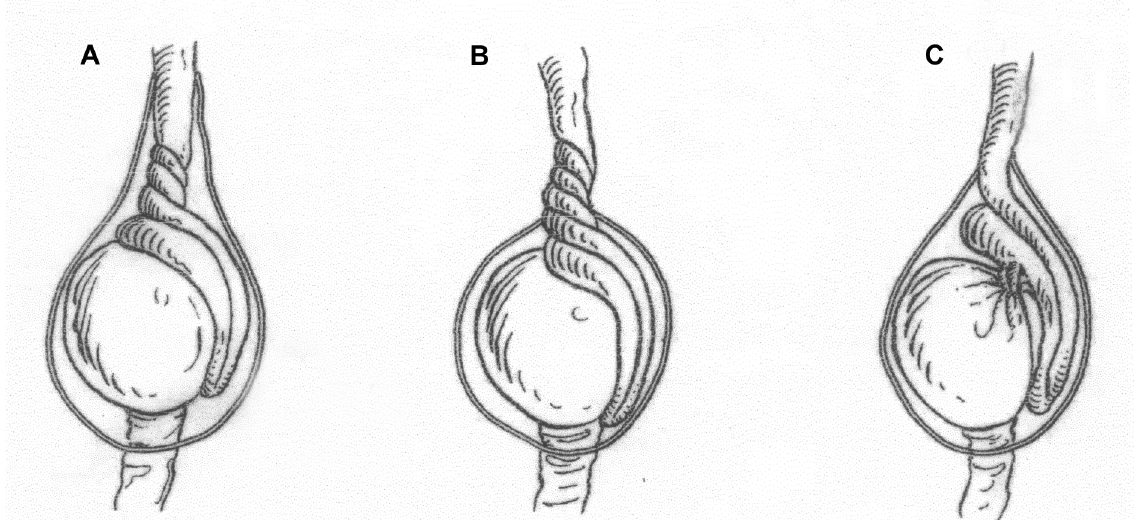
Figure 1 – Classification of types of testicular torsion. A) Intravaginal torsion; B) Extravaginal torsion; C) Torsion due to long